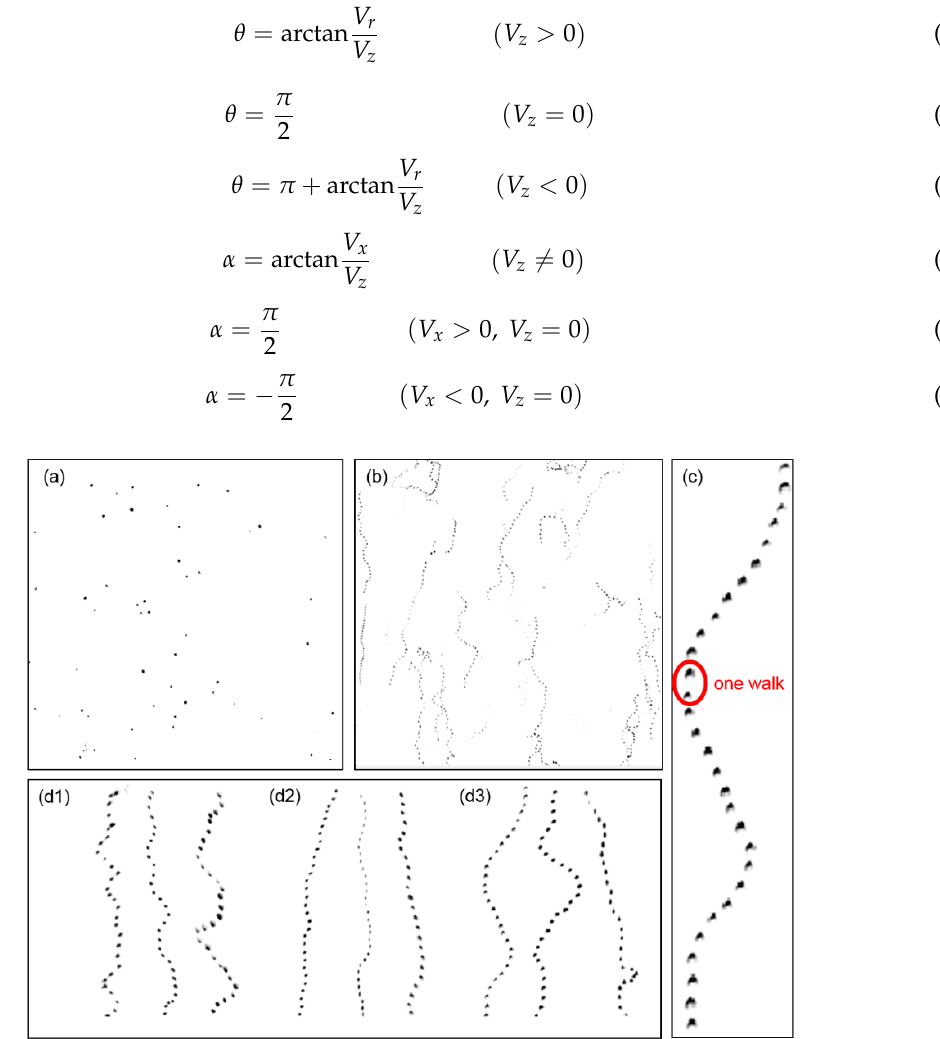
Figure 3. Images of motile cells: ( a ) algal cells (represented by dark spots) in one frame, ( b ) trajectories of cells in 30 frames, ( c ) one track/trajectory with dozens of walks, and three swimming patterns: ( d1 ) helical trajectories, ( d2 ) straight trajectories, and ( d3 ) trajectories combined helical and straight ones.